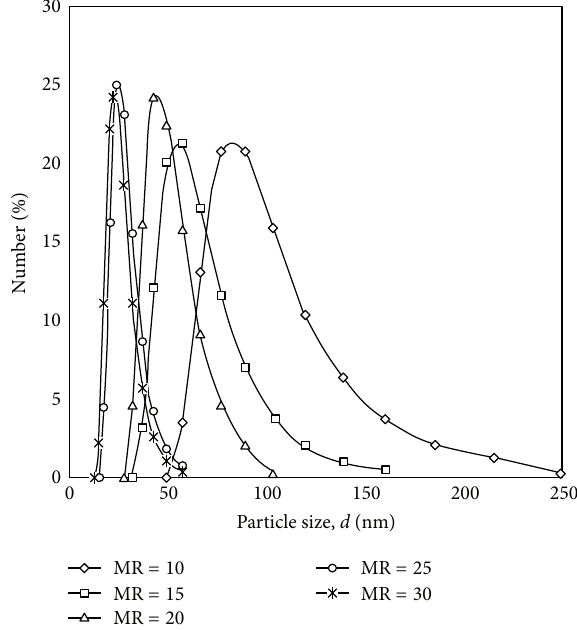
F 1: Study of effect of SDS/RuCl particle-size analyser.